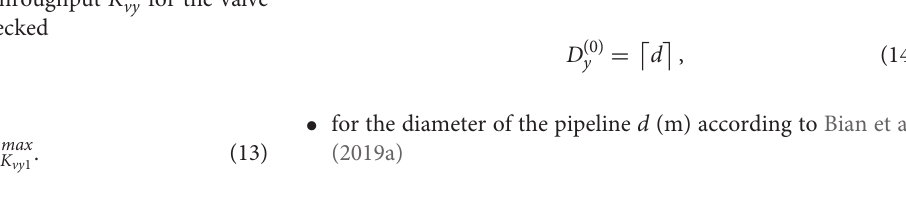
the liquid; η 1 and η 2 are safety factors in the range of at least K vmax according to Arzumanov (1971), for example, η 1 δ min is 1 p min